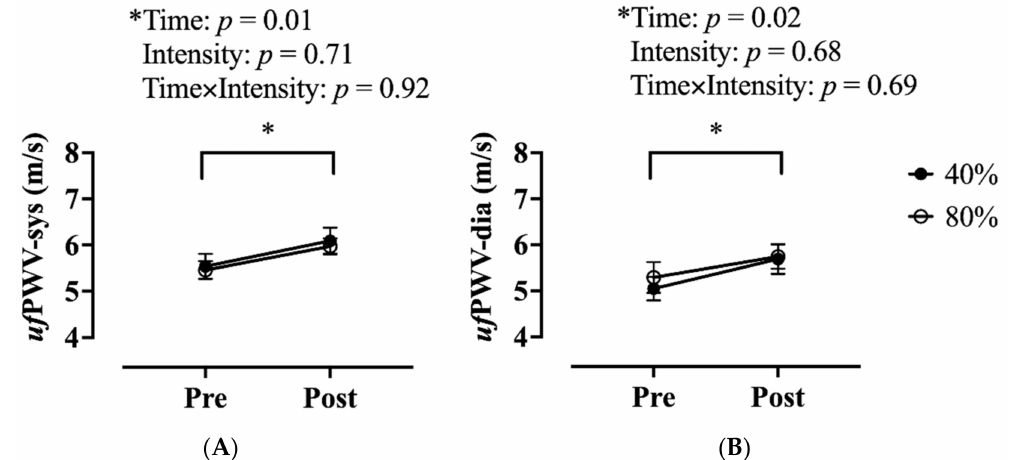
Figure 4. Pre- and post-exercise uf PWV-sys ( A ) and uf PWV-dia ( B ) in response to different exercise intensity. * = vs. Pre.